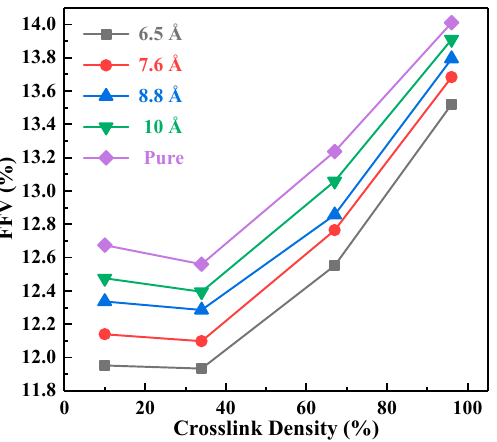
Figure 4. The Fraction of Free Volume ( FFV ) of each system with different crosslinking densities.